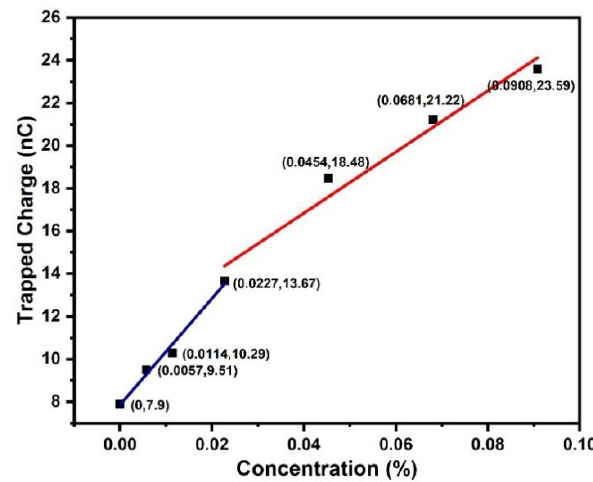
Figure 9. Amount of released charges versus particle concentration level.